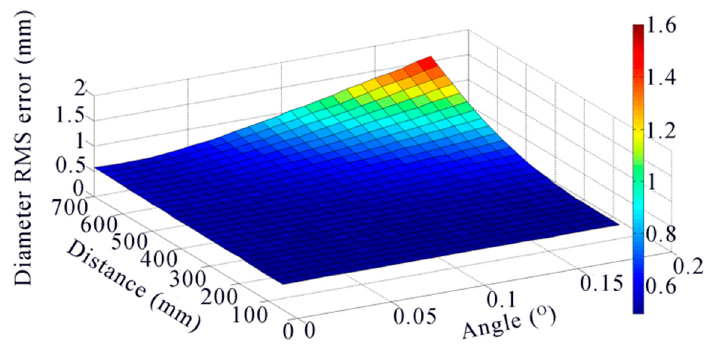
Figure 15. Diameter RMS error to the angle of bending and the distance from O1 to the rim plane.